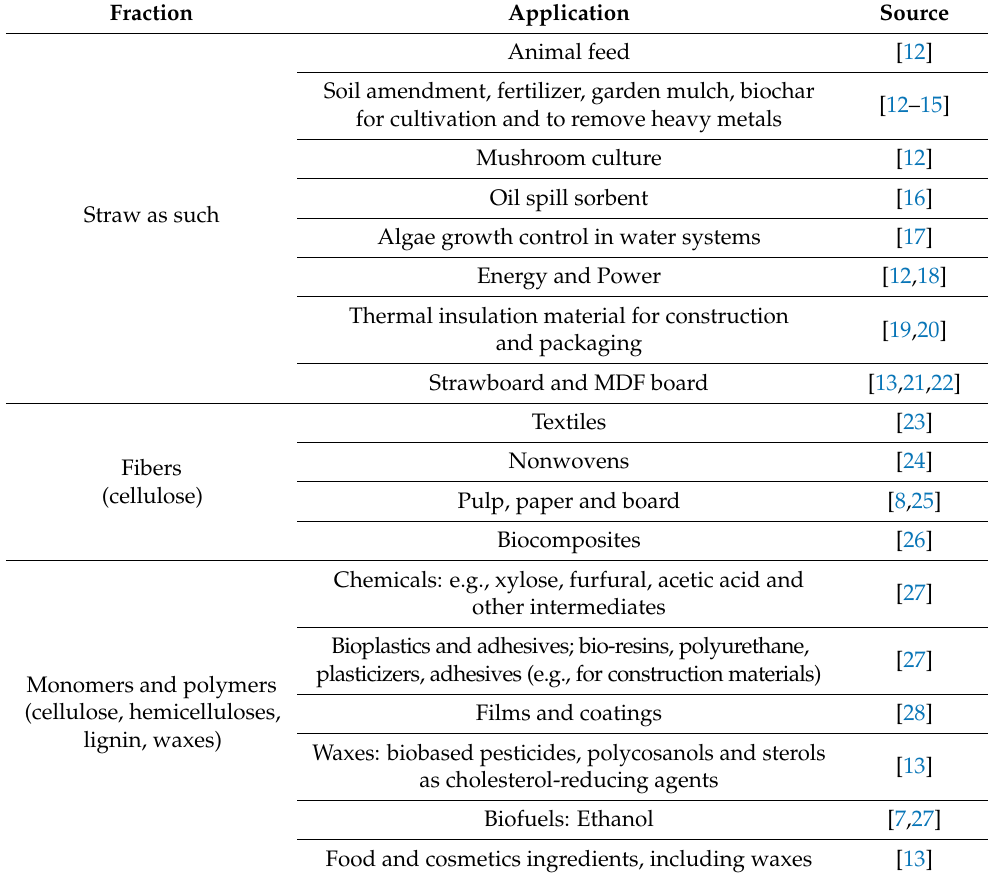
Table 1. Examples of current applications for cereal straw (barley and